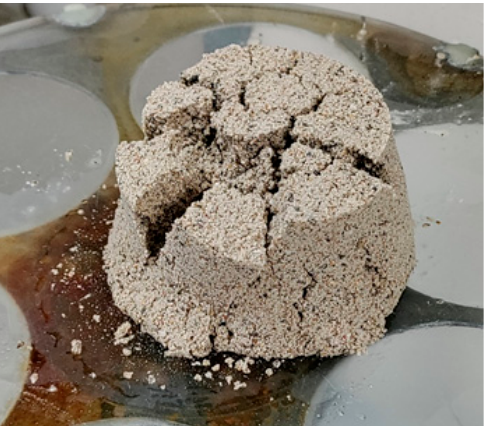
Figure 6. Appearance of the Labo CSA cement mortar on the shaker table.